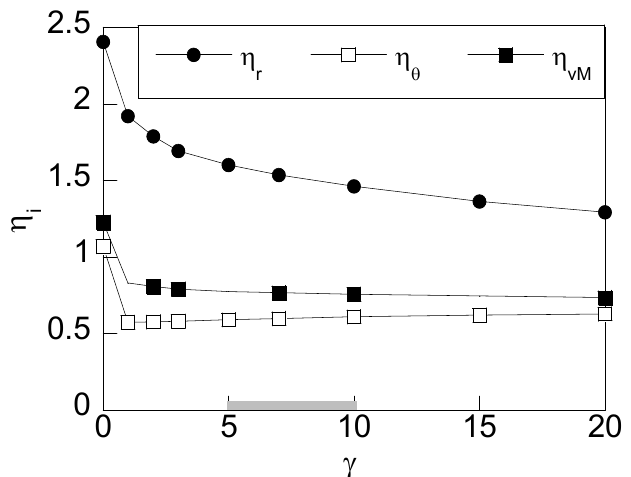
Figure 13. Variation of the parameter η radial, tangential, and von Mises as a function of the contact ring thickness ratio.